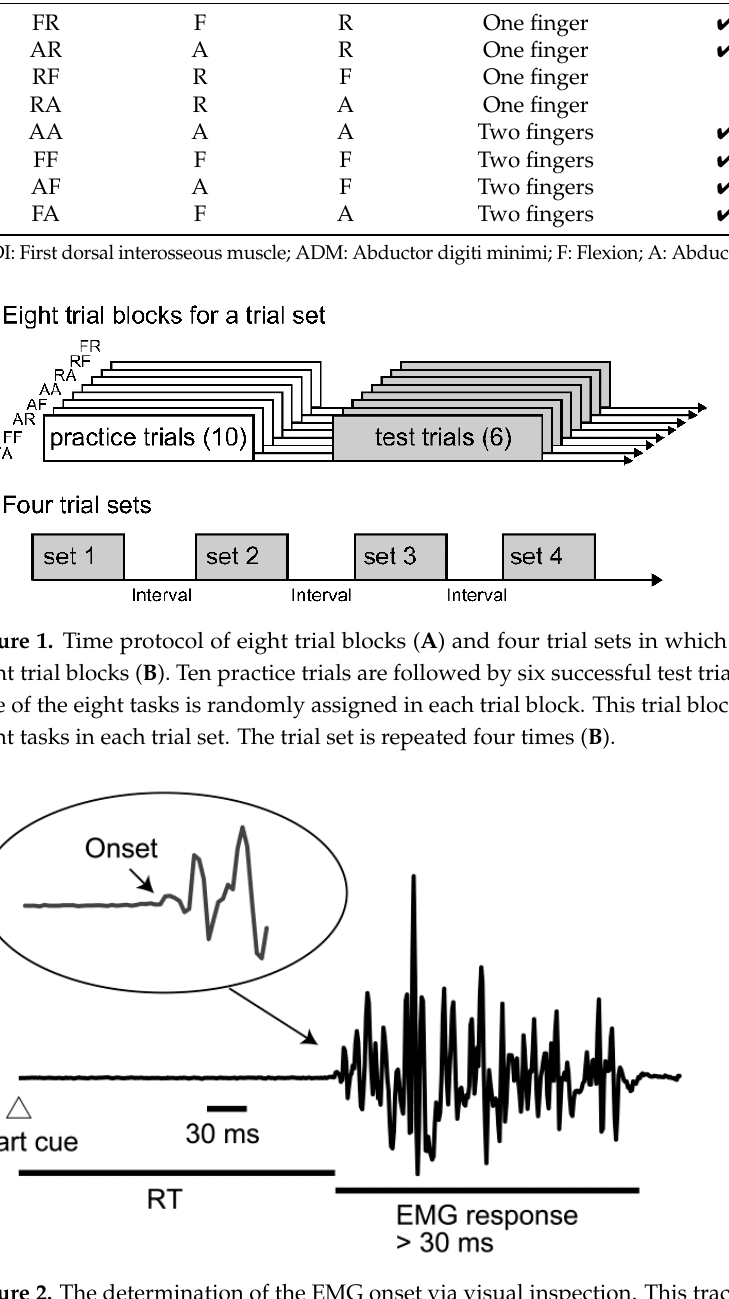
Figure 2. The determination of the EMG onset via visual inspection. This trace is an example of the EMG response in the experiment. The onset of the EMG response is determined on the basis of the earliest rise or decline in EMG activity beyond the steady state for the earliest EMG response that continued for more than 30